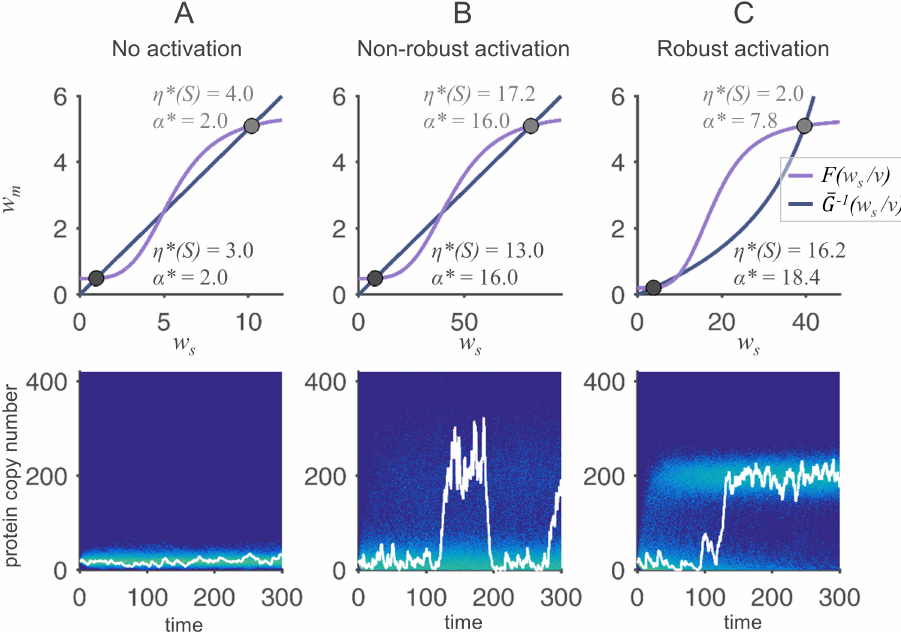
Fig 5. Stochastic simulations of bistable autostimulatory reaction systems. In the upper part, w different regulatory systems with similar protein levels in the active states are shown. The plots in the lower part show the results of 500 simulations of corresponding protein time courses, initialized in the inactive state. The protein distributions are visualized by color plots. One exemplary time course is highlighted in white. (A): Linear translation rate. Protein bursts are too small to activate the system. F s ð Þ ¼ 0 : 49 þ 5 s 4 emerge through accelerated protein dynamics (increase in ν ), leading to random activation and inactivation events. Parameters as in (A), except for ν = 0.4. (C): System with saturated translation rate. Bursts occur in the inactive state, but are attenuated in the active state, leading to a bimodal, robust activation of the system. F s ð Þ ¼ 0 : 2 þ 5 : 12 s 4 , ν = G m ð Þ ¼ 290 m m þ 2